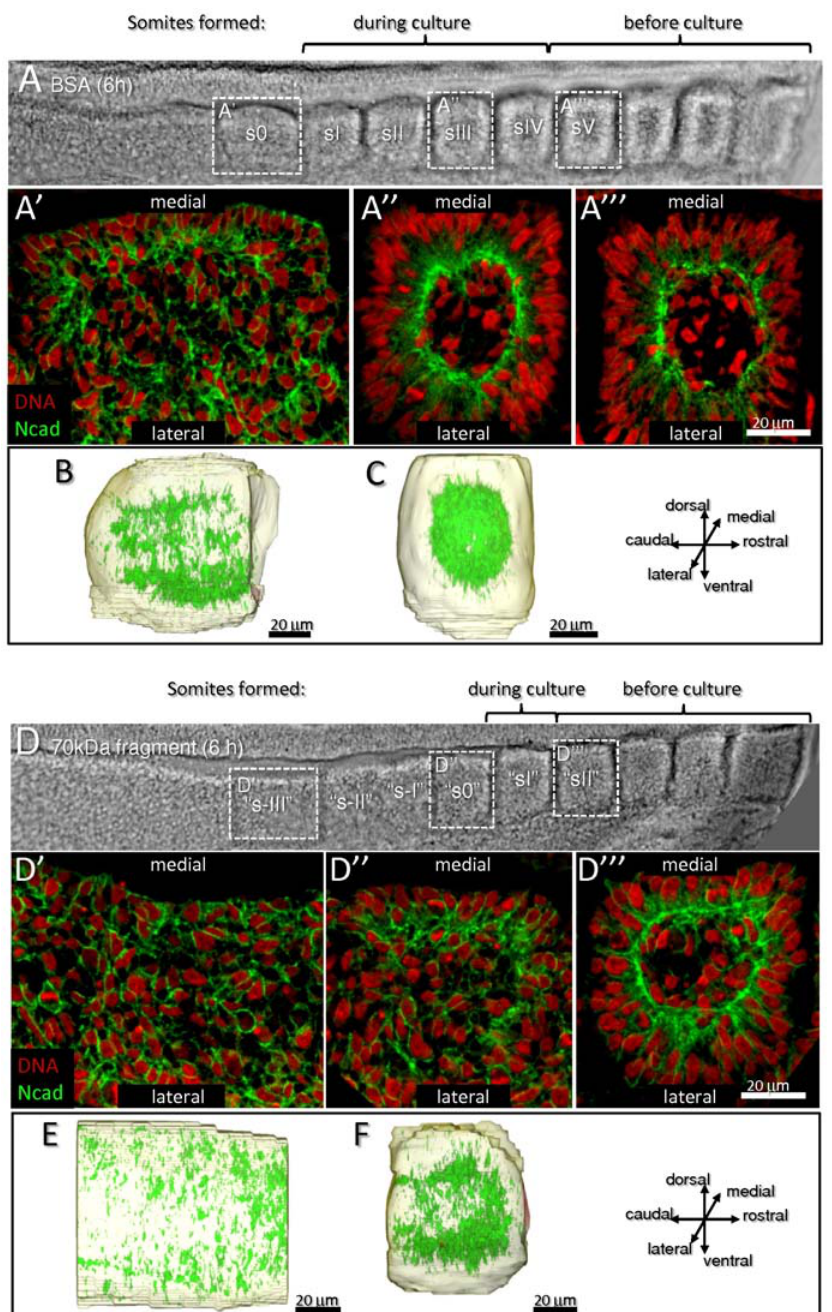
Figure 4. N-cadherin fails to polarize apically when FN fibrillogenesis is inhibited. Bright field (A, D), coronal confocal sections (A 9 , A 0 , A 09 , D 9 , D 0 , D 90 ) of control (A) and 70 kDa FN fragment-treated (D) explants cultured for 6 hours, immunostained for N-cadherin (green) and labeled for DNA (red) and 3D surface reconstruction with N-cadherin labeling (green in B,C,E,F) of selected volumes. A ) Control explants form four new somites. In s0 (A 9 ), medial cells are starting to elongate and to polarize their N-cadherin apically. In sIII (A 0 ) and sV (A 09 ), cells have become centripetally aligned, with oval-shaped nuclei and apically restricted N-cadherin immunoreactivity. B–C ) Lateral view of N-cadherin labeling shows a ‘‘3D adhesion basket’’ in s0 (B). By sIII (C) the N-cadherin labeling has become more apically restricted and has closed rostrally and laterally thus forming a ball. D ) 70 kDa fragment-treated explants form one or two somites; the depicted embryo formed one (‘‘sI’’) and has an advanced ‘‘s0’’. The tissue at the same axial level as A 9 (‘‘s-III’’, D 9 ) shows no sign of epithelialization or cell elongation. Medial cells in the forming somites of 70kDa fragment-treated explants (‘‘s0’’, D 0 ; axially equivalent to A 0 ) show incipient elongation and N-cadherin polarization. Cells of somites that had formed before culture (‘‘sII’’, D 09 ) are less polarized and less elongated than cells at the equivalent axial level in control explants (sV). E–F ) Lateral view of N-cadherin labeling in 70kDa fragment-treated explants show dispersed N-cadherin localization in the ‘‘s-III’’ (axial equivalent to B). The ‘‘s0’’ (axial equivalent to C) depicts a more intense labeling in the rostral portion, resulting in an ‘‘adhesion basket’’ that is opened caudally.